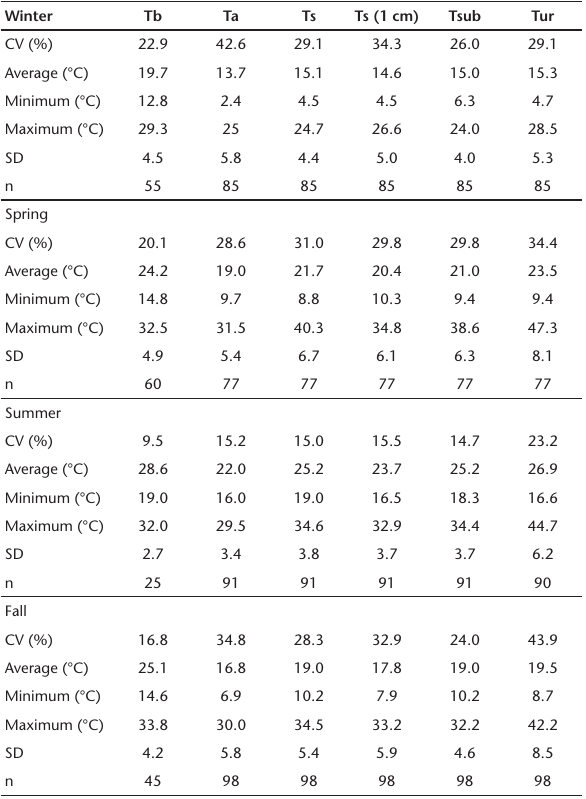
Table 2. Seasonal variations in the body temperatures of Amphis- baena munoai and the environmental temperatures at São Jerônimo between March 2011 and October